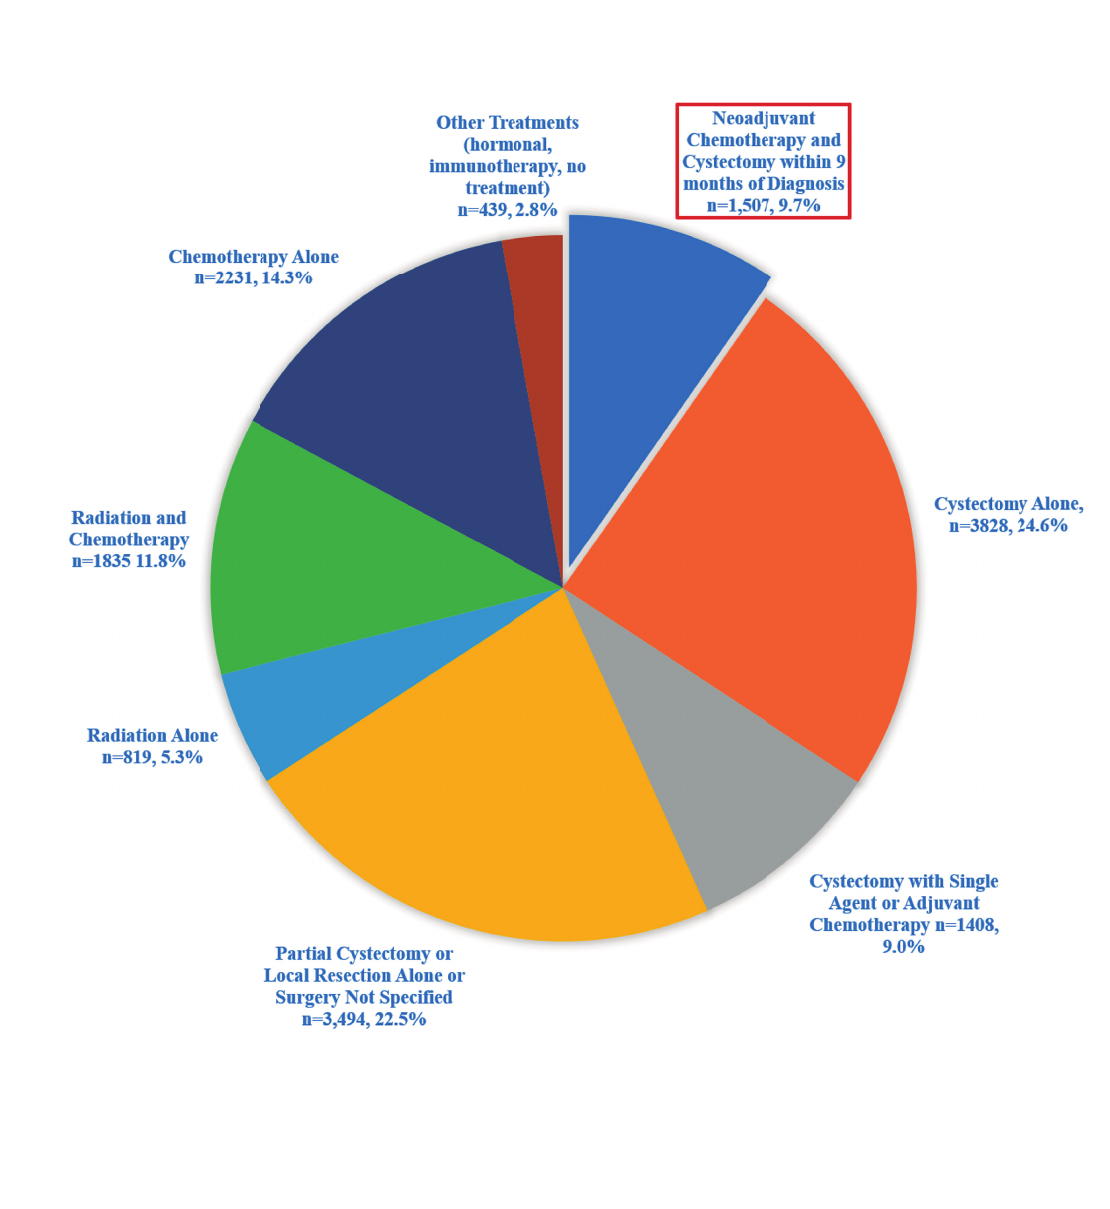
Figure 2 - Rates of treatment utilization 2006-2015 in U.S National Cancer Databe non-matastatic muscle invasive baldder cancer patients with Charlson comorbidity